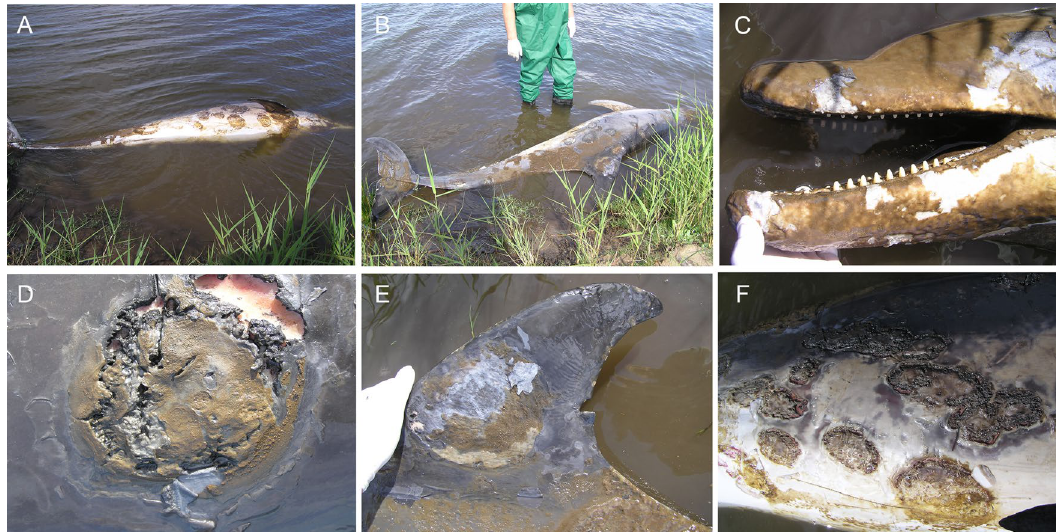
Figure 2. Adult female T. australis (case 1) found dead with severe ulcerative dermatitis at Jones Bay, Lake King North, near the mouth of the Mitchell River, 29th October, 2007. Discrete circular to confluent areas of epidermal thickening and ulceration, with overgrowth of algal mats, are randomly distributd on both sides of the body from the rostrum to tail flukes ( A , B ). Locally extensive algal mats on the head, melon, rostrum and mandibles ( C ). Closer view of a large raised, targetoid, focally ulcerated, circular plaque on the thorax with a thickened surface discolored yellow–brown ( D ). The dorsal fin has a large circular area of erosion and ulceration extensively overgrown by algae and similar dense algal mats are apparent on the dorsal trunk ( E ). The abdomen and thorax have focally extensive ulcers and plaques with overgrowth of algal mats ( F ).